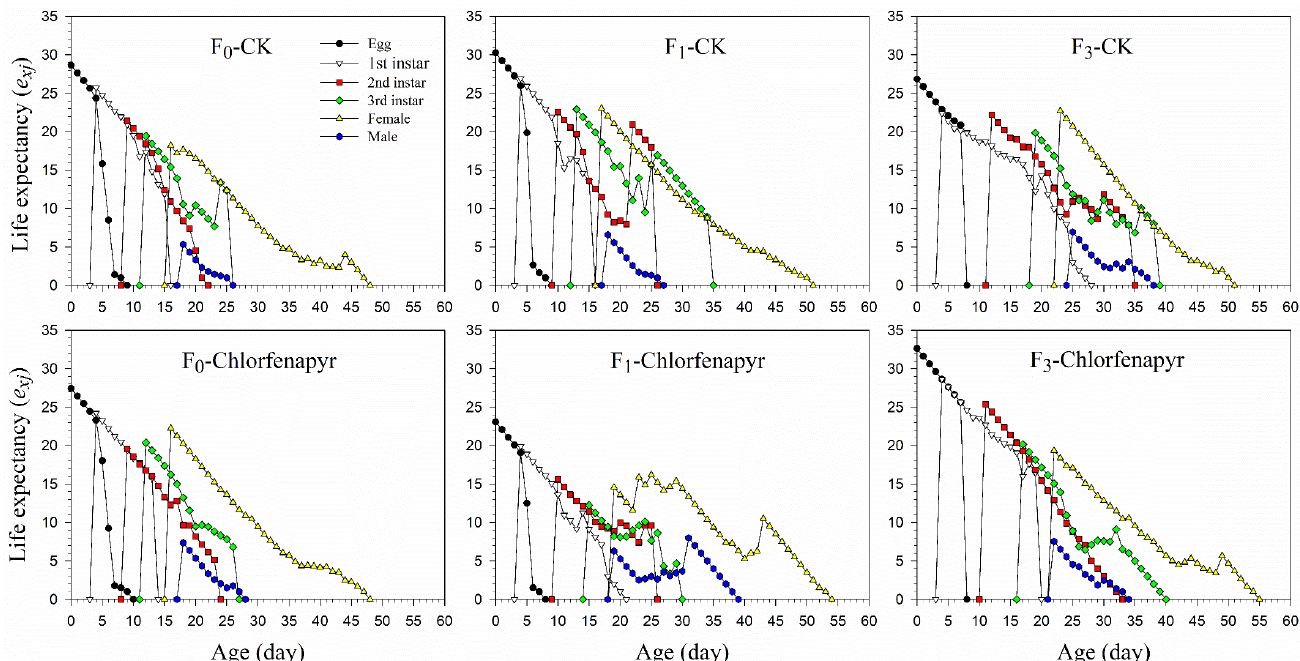
Figure 4. Age-stage-specific life expectancy ( e xj ) of P . marginatus (F 0 , F 1 , and F 3 ) exposed to LC 30 dose of chlorfenapyr. CK represents the control.